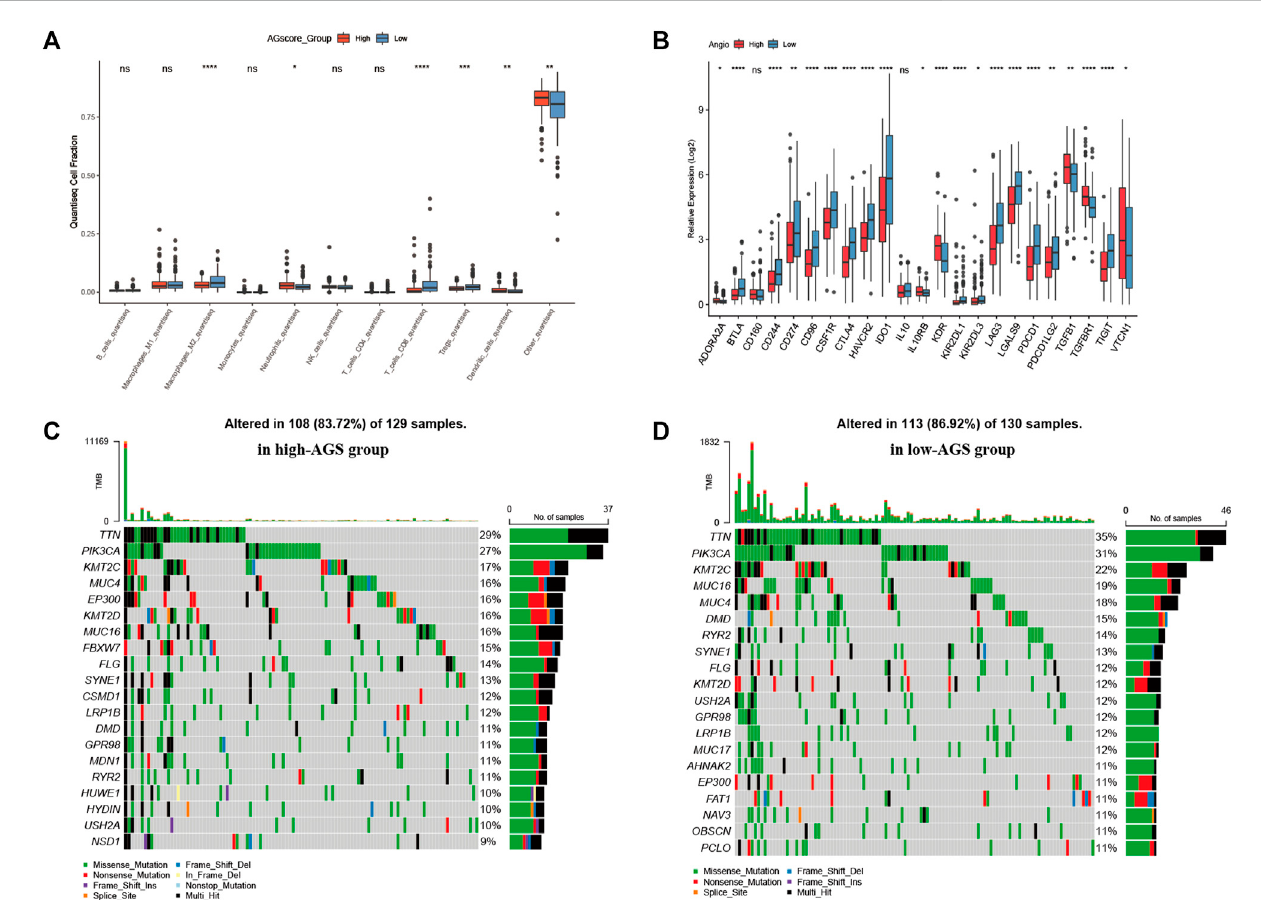
FIGURE 4 Immune in fi ltration, tumor mutational burden, and proteomic analysis. (A). Expression of 10 types of immune cells in high-AGS group and low-AGS group. (B) .Differential expressionofimmunecheckpointrelated genesinhigh-AGS groupand low-AGS group. (C) .Mutation landscapeinhigh-AGSgroupof TCGA cohort. (D) . Mutation landscape in low-AGS group of TCGA cohort. (* < 0.05, ** < 0.01, *** <